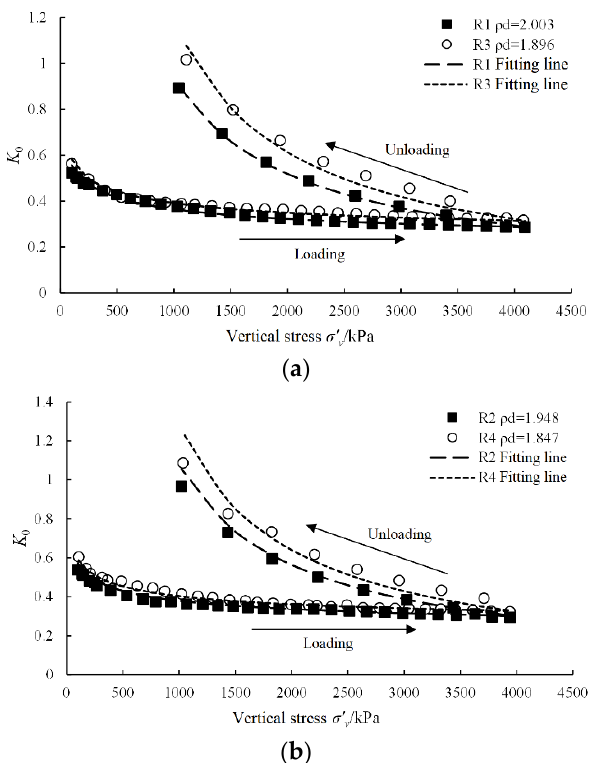
Figure 5. K 0 – d M curves. ( a ) S1 and S3. ( b ) S2 and S4.